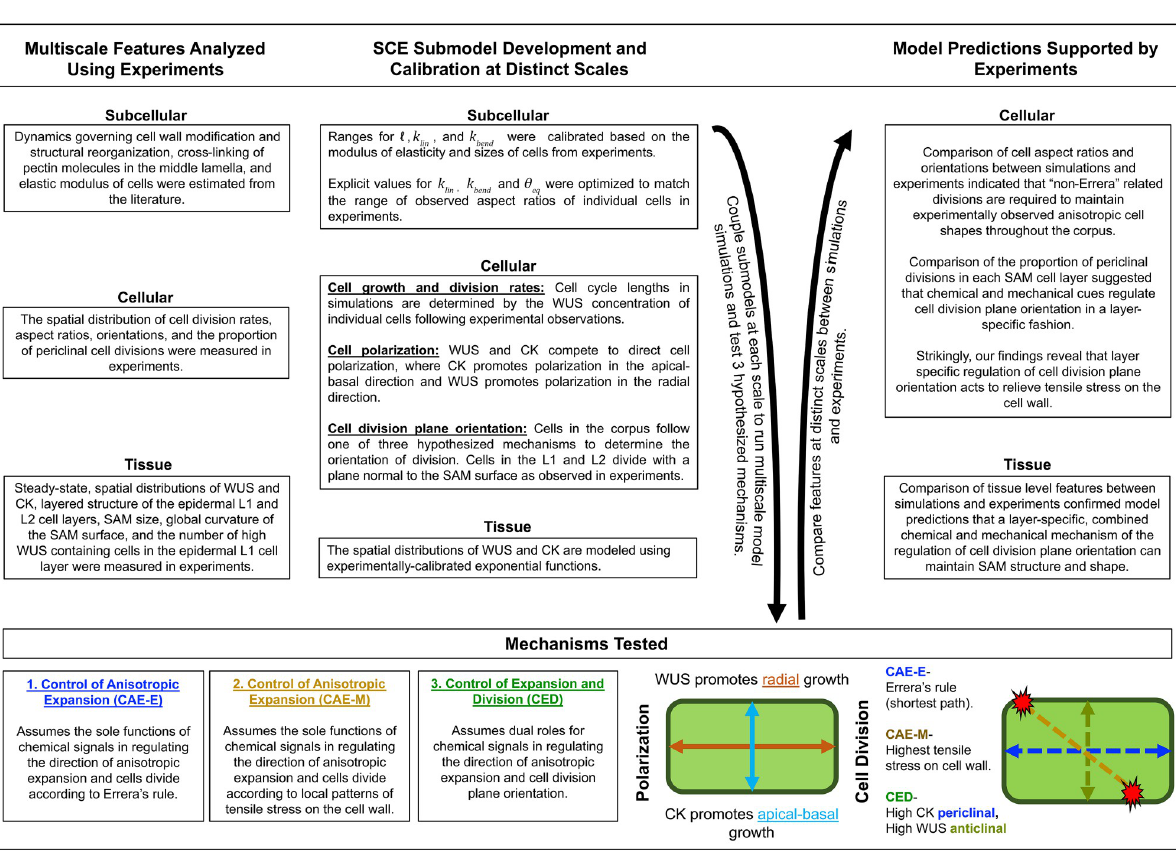
Fig 1. Combined multiscale modeling and experimental study workflow outline. Data from experimental studies was used to develop and calibrate submodel components at distinct scales. Multiscale model simulations were used to test three hypothesized mechanisms of the regulation of cell division plane orientation in the corpus. Results from perturbation experiments were used to support model